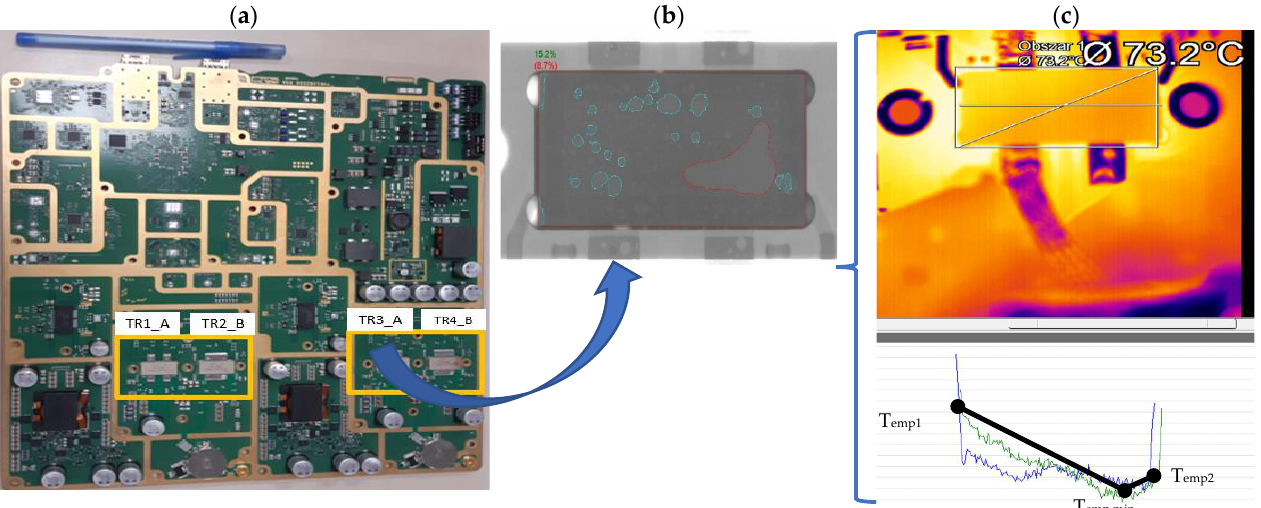
Figure 4. Tested electronic module ( a ), an example of the distribution of voids tested by the X-ray method ( b ), an example of a thermogram and case temperature distribution for the BLC10G22LS- 240PVT transistor at the dissipated power P = 21.5 W for the transistor at position 3 in the electronic module described as PCB2 ( c ).